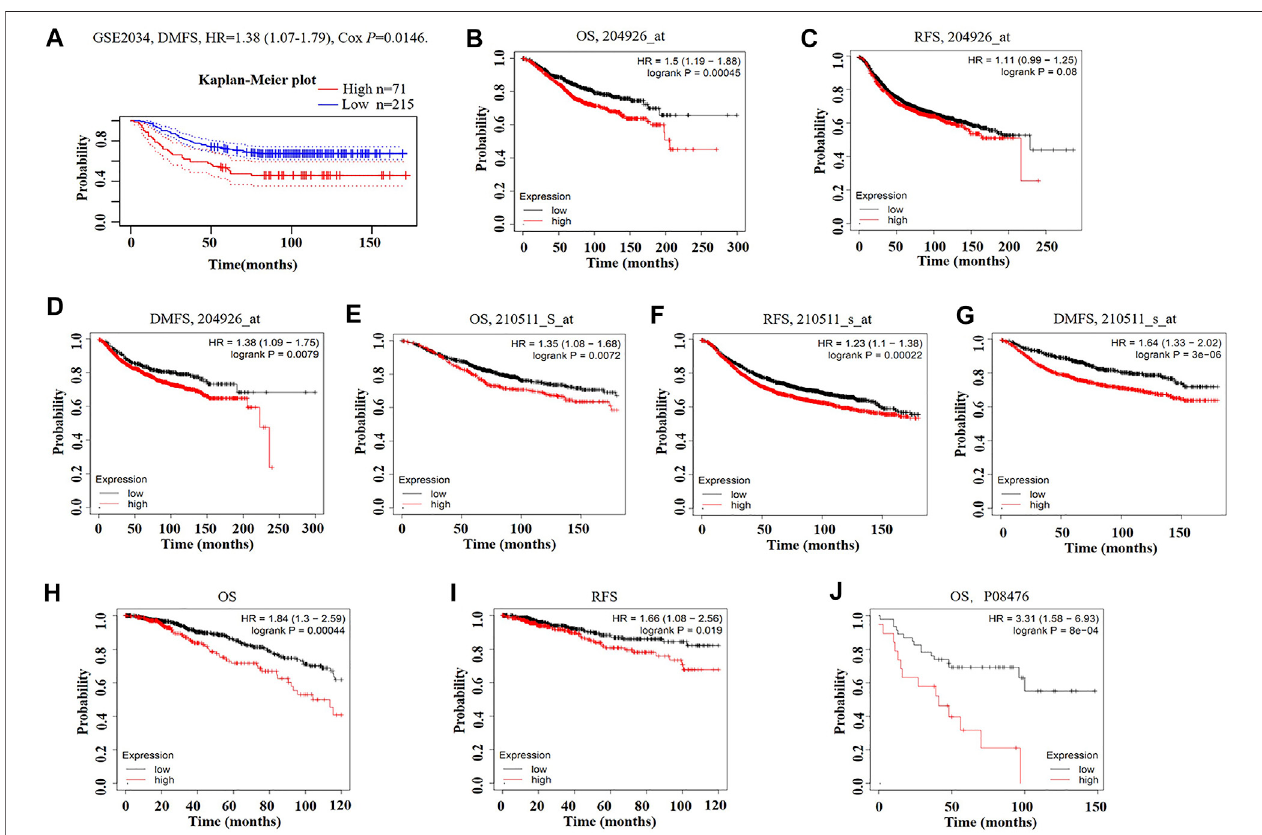
FIGURE 3 | Kaplan – Meier survival curves comparing high and low expression of INHBA in breast cancer in PrognoScan (A) and Kaplan – Meier plotter databases (B – J) . (A) SurvivalcurvesofDMFSinbreastcancercohort[GSE2034( n =286)]. (B – D) OS,RFS,andDMFSsurvivalcurvesofbreastcancerusingprobeset204926_at ( n = 1,402, n = 3,951, n = 1,746). (E – G) OS, RFS, and DMFS survival curves of breast cancer using probe set 210511_s_at ( n = 1,402, n = 3,951, n = 1,746). (H, I) OS and RFS survival curves of breast cancer using pan-cancer RNA-seq ( n = 1,089, n = 947). (J) Relationship between INHBA protein expression and OS in breast cancer ( n = 65). OS, overall survival; RFS, relapse-free survival; DMFS, distant metastasis-free